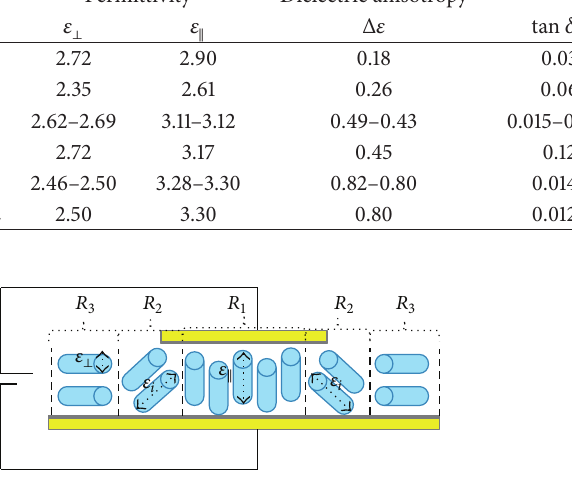
Table 1: Properties of liquid crystals at 20 ∘ C temperature, as specified at the given operating frequency. Samples